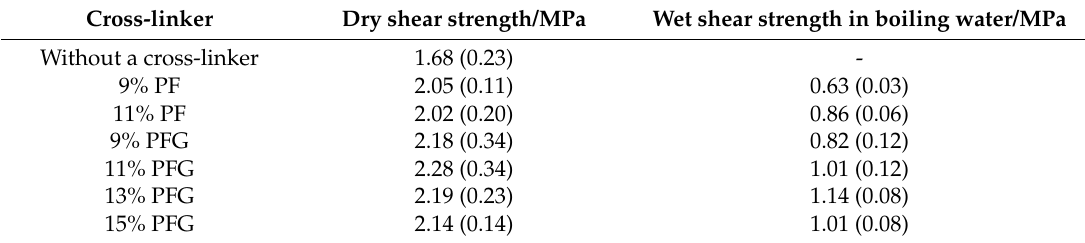
The performance of soy-based adhesives with cross-linker phenol-formaldehyde or phenol-formaldehyde-glutaraldehyde resin.